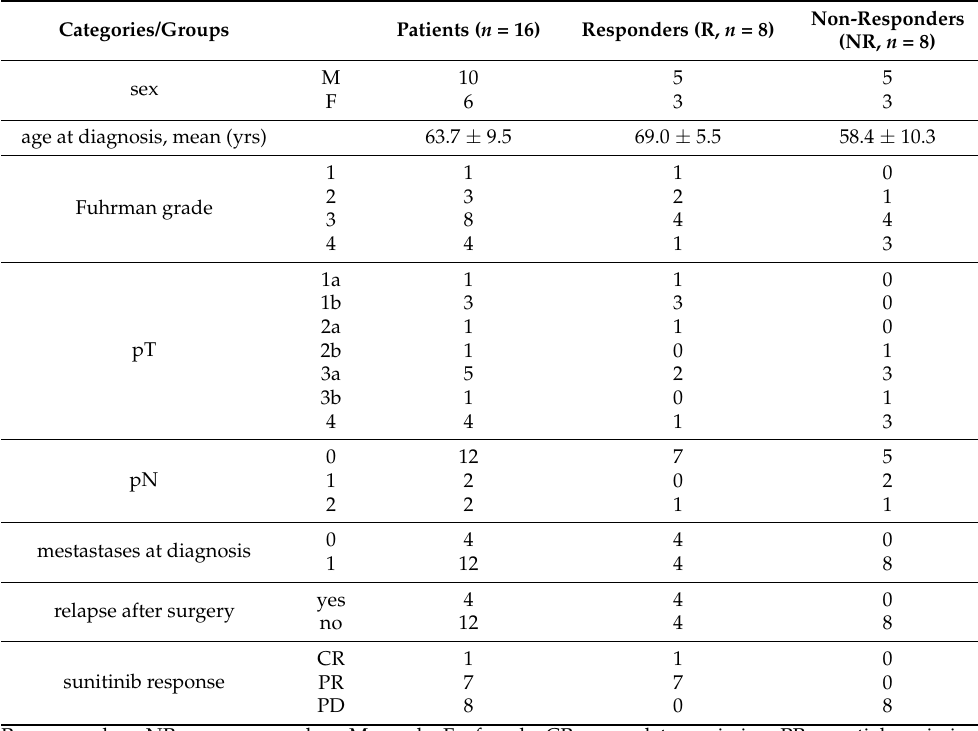
Table 1. Clinicopathological characteristics of patient